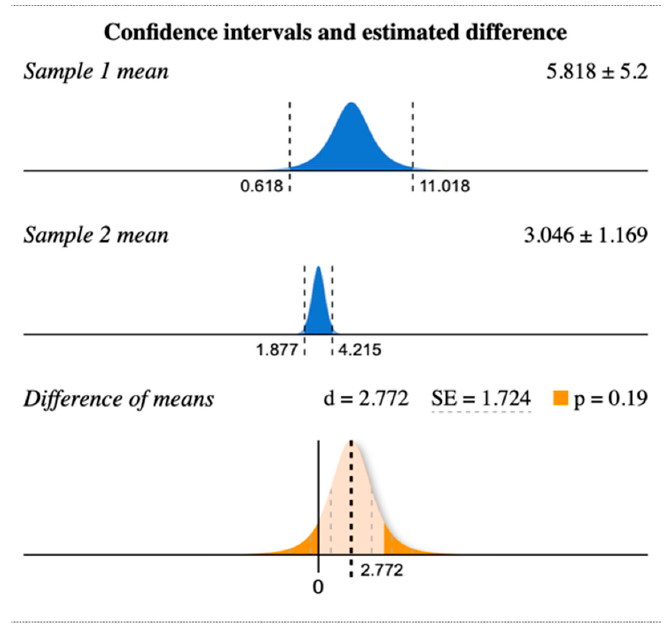
Figure 3. Difference of mean SUV of patients with Moderna mRNA1273 (sample 1) and mean SUV of patients with Pfizer BNT162b2 mRNA (sample 2). (www.evamiller.org) . After finding positive lymph nodes on a PET-CT scan performed for staging pur- poses, one patient had to undergo lymph node dissection. We obtained the pathological confirmation of inflammatory/benign axillar adenopathies in the context of COVID19 vac- cination for this patient, who was originally suffering from malignant melanoma (Figure 4).